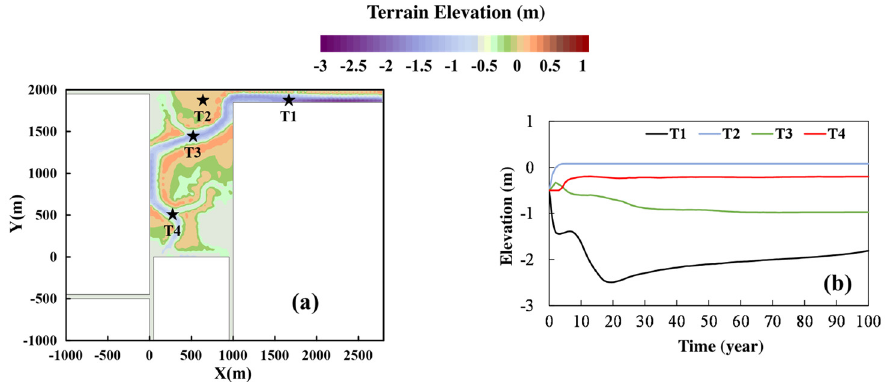
Figure 7. ( a ) Location of the observation points T1, T2, T3, and T4; ( b ) Elevation change within 100 years at T1, T2, T3, and T4.